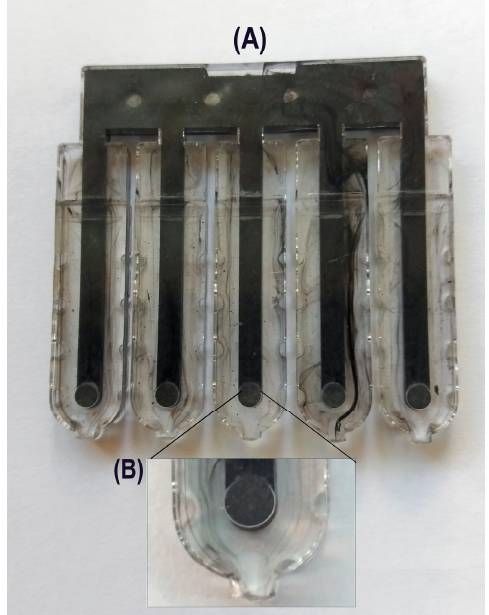
Figure 1. ( A ) Photograph of a batch of five injection molded sensors; ( B ) Magnification of the active sensing area of a single sensor.